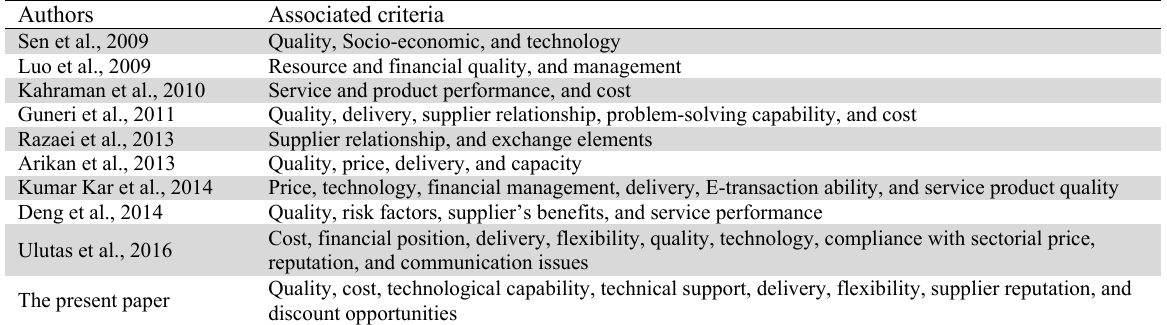
Summary of supplier selection criteria in prior